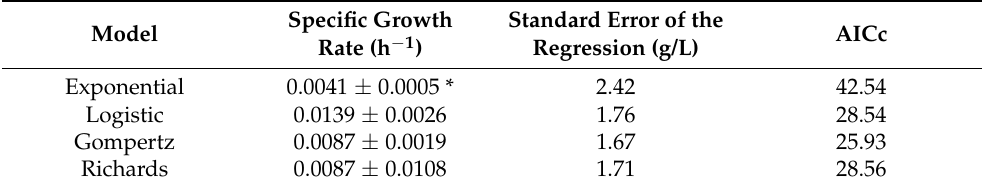
Table 6. Specific growth rate of Ganoderma sp. in the submerged culture obtained from different growth models.